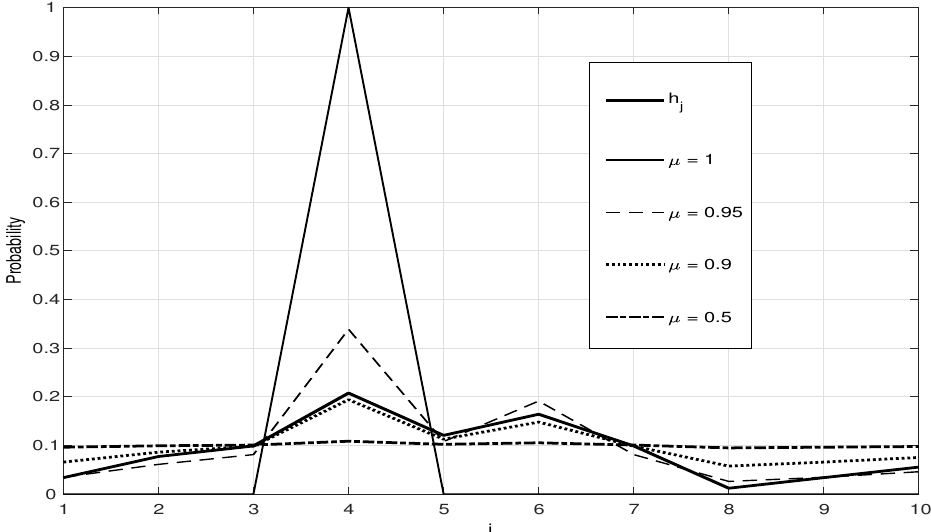
Figure 1. Output probability vector, δ j , given average transition probabilities, h j = { 0.04,0.09,0.1,0.22,